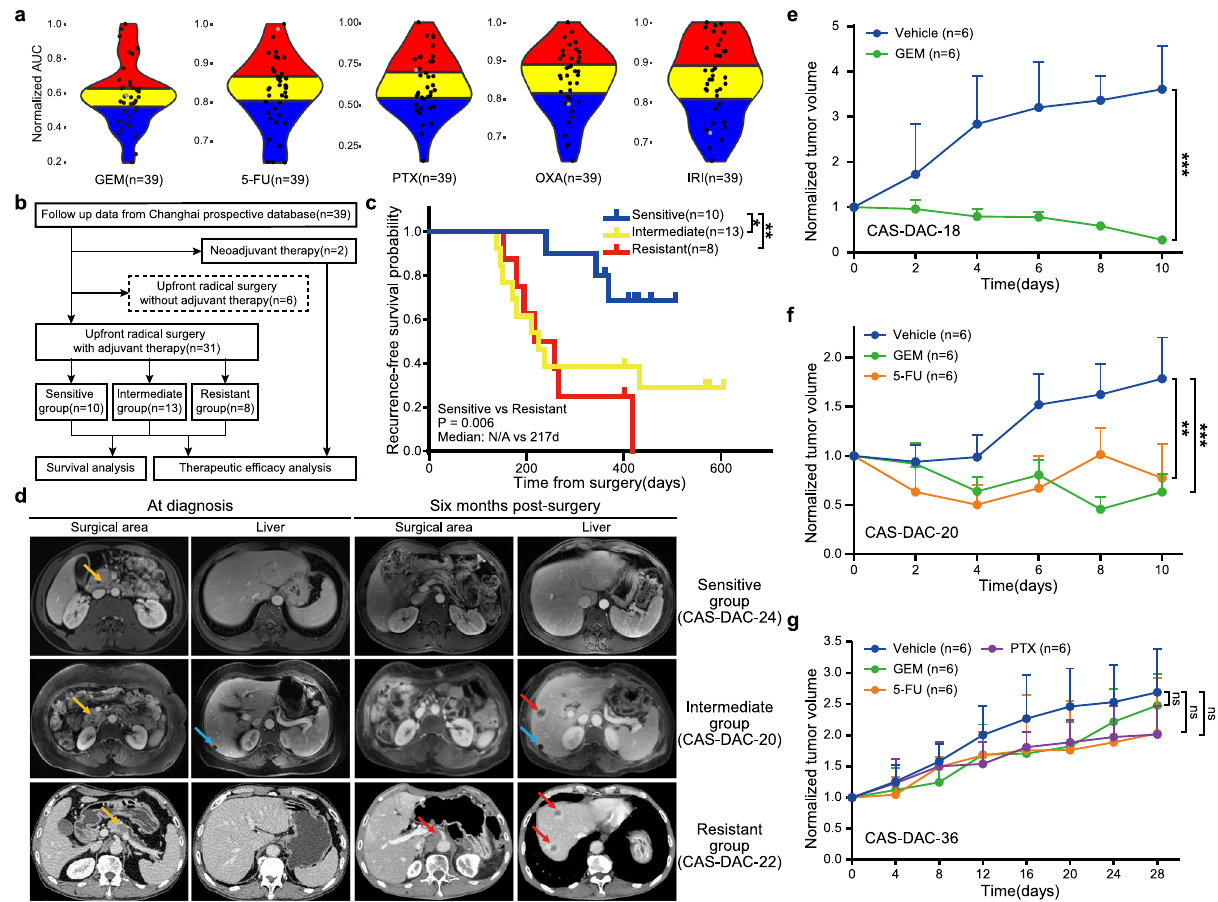
Fig. 6 Clinically relevant chemosensitivity of PDPCOs with validation in in vivo xenograft models. a AUCs of 5 chemotherapeutic agents in 39 exocrine PDPCOs (38 CAS-DACs and 1 CAS-IPMN). With respect to each chemotherapeutic agent, the 39 PDPCOs were divided equally into sensitive (blue, AUC lowest 1st-13th), intermediate (yellow, AUC lowest 14th – 26th) and resistant (red, AUC lowest 27th – 39th) groups. The gray dot indicated CAS-DAC-14. b Diagram of the clinical analysis work fl ow. c Kaplan-Meier survival analysis showing the recurrence-free survival outcomes of the patients corresponding to the 39 PDPCOs. P value is determined by using log-rank test. Based on the consistency between the clinical adjuvant chemotherapy regimen and chemosensitivity of the matched organoid, three groups were identi fi ed: sensitive ( n = 10), intermediate ( n = 13) and resistant ( n = 8). d Representative radiation examination of both the surgical area and liver in the sensitive group (CAS-DAC-24, CE-CT), intermediate group (CAS-DAC-20, CE-MRI), and resistant group (CAS-DAC-22, CE-MRI) at the time of diagnosis and six months post-surgery. Yellow arrow, primary tumor; Blue arrow, hepatic cyst; Red arrow, metastasis. e Drug test of ODX-18 with GEM (n = 6), using Vehicle as a control ( n = 6). Data are presented as mean values + SEM. Statistical Signi fi cance was computed by two-sided unpaired t test. Source data are provided as a Source Data fi le. f Drug test of ODX-20 with GEM ( n = 6) and 5-FU ( n = 6), using Vehicle as a control ( n = 6). Data are presented as mean values + SEM. Statistical Signi fi cance was computed by two-sided unpaired t test. Source data are provided as a Source Data fi le. g Drug test of ODX-36 with GEM ( n = 6), 5-FU ( n = 6) and PTX ( n = 6), using Vehicle as a control ( n = 6). Data are presented as mean values + SEM. Statistical Signi fi cance was computed by two-sided unpaired t test. Source data are provided as a Source Data fi le. Statistical analysis, ns P ≥ 0.05,* P < 0.05, ** P < 0.01, *** P < 0.001. PDPCO, patient-derived pancreatic cancer organoid; AUC, area under curve;